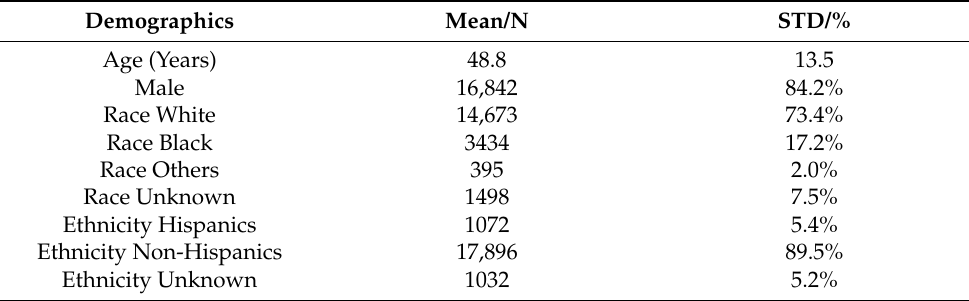
Table 2. Baseline characteristics of the randomly selected 20,000 BD patients.